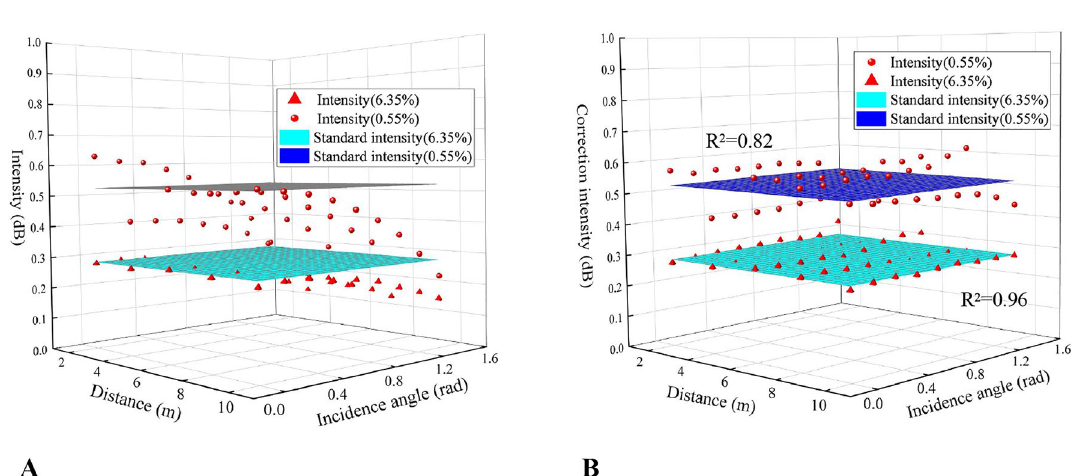
Figure 9. Intensity value before correction ( A ) and after correction ( B ) with the standard intensity of the normal incidence angle and 6 m (Software: Riscan pro 2.1; riscan-pro.software.informer.com; Origin 2021b; https:// www. origi nlab. com/ index. aspx? go= PRODU CTS/